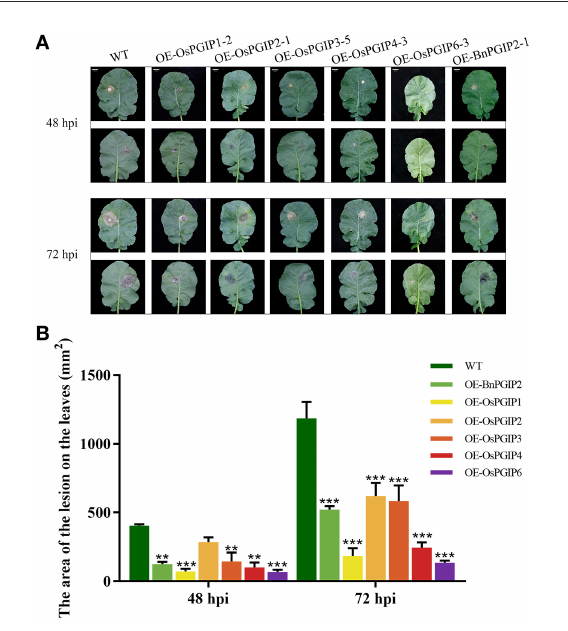
FIGURE6 OsPGIPx overexpression conferred resistance to S. sclerotiorum in Living leaves inoculation. (A) Living leaves of overexpression lines and non-transgenic line inoculated with 10-mm agar plugs of S. sclerotiorum hyphae at 22 ◦ C. Lesion on living leaves at 48 and 72 hpi. Scale bars are 20mm. (B) Lesion on living leaves at 48 and 72 hpi. Significant differences were showed by: *** P < 0.001, ** P < 0.01. Error bars indicate SE based on five independent biological